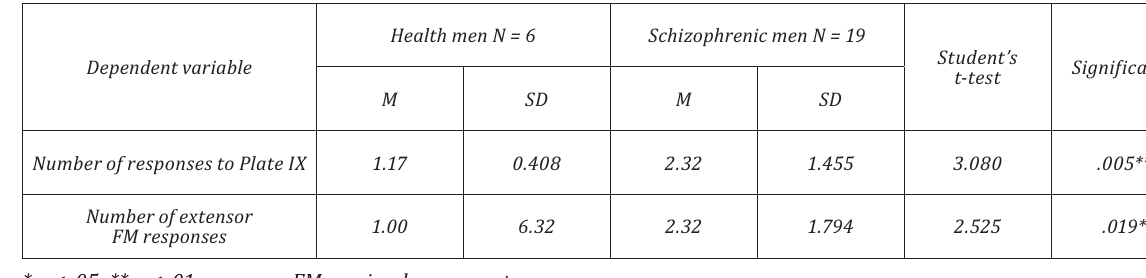
Table 3. Differences and the significance of differences in selected variables between the groups of healthy and schizophrenic